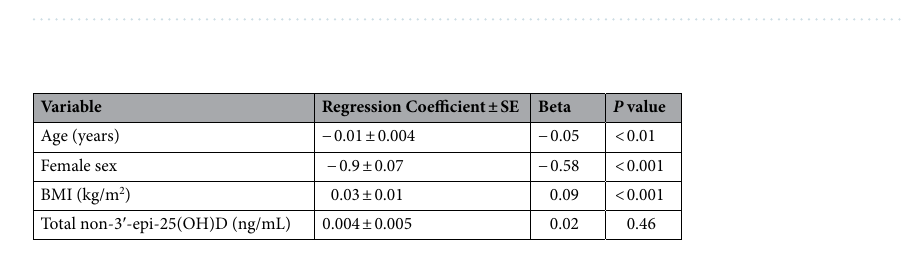
Table 3. Association between total 3 ′ -epi-25(OH)D and haemoglobin levels. Total 3 ′ -epi-25(OH)D was associated with haemoglobin levels, independently of age, sex, and BMI.